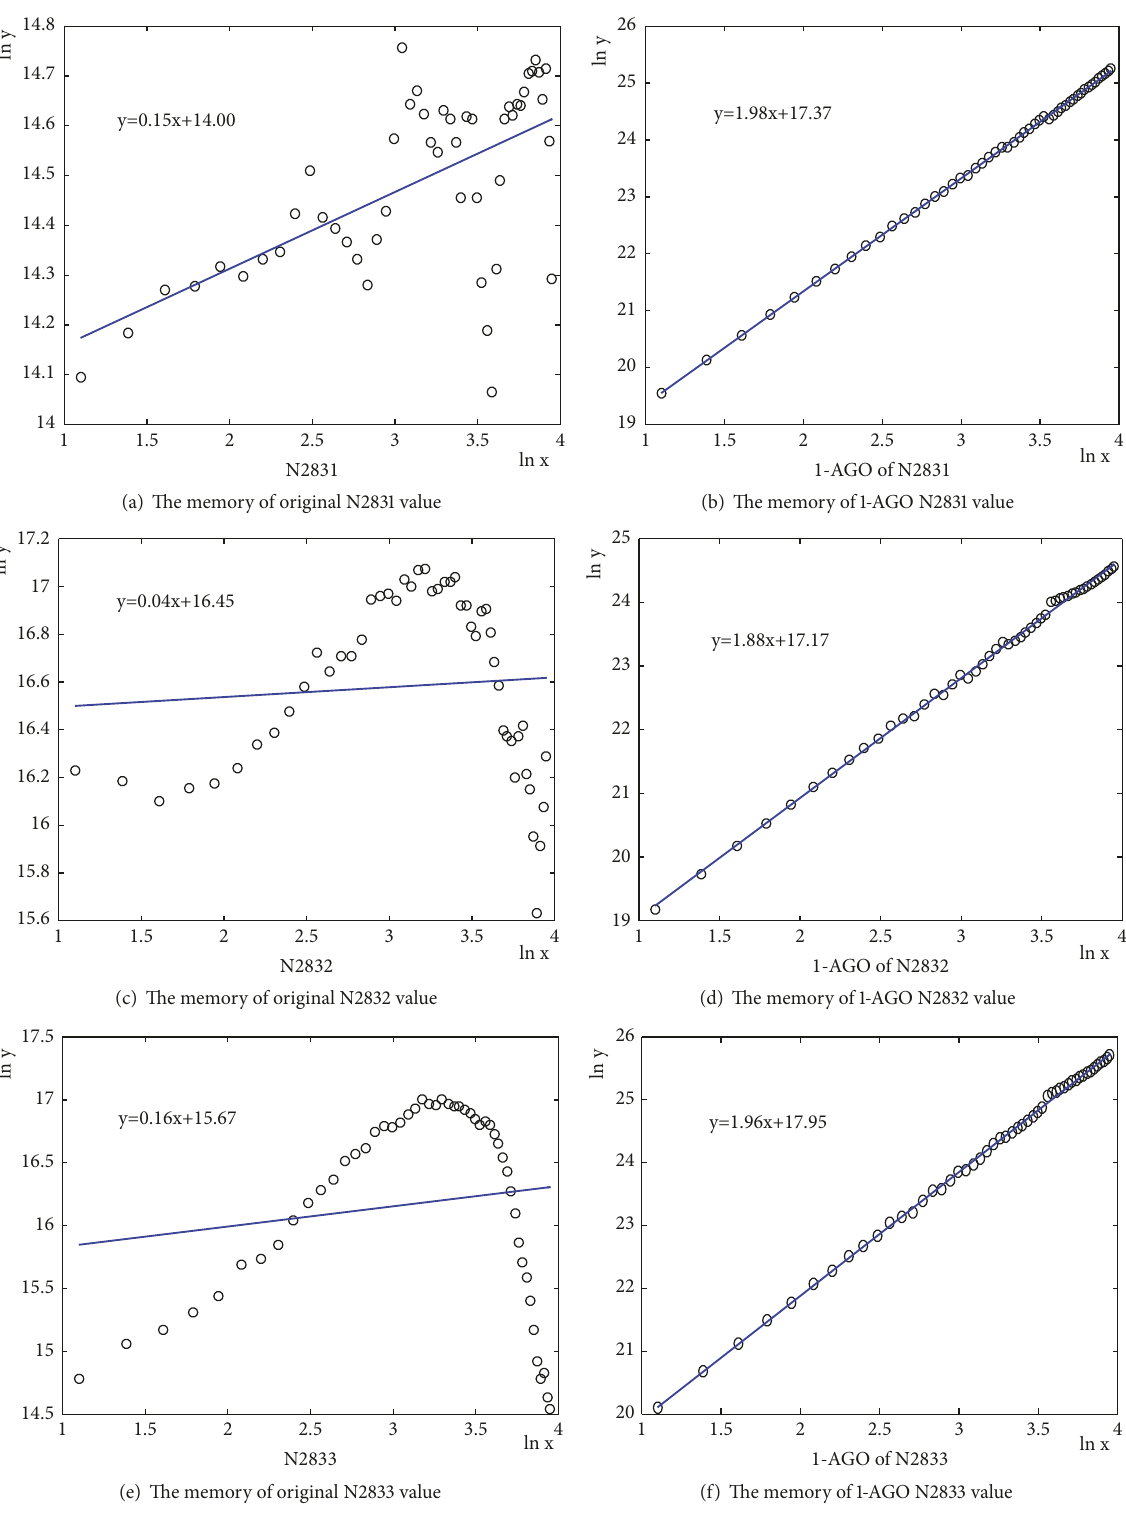
Figure 2: The memory of original value and one-order accumulation value for three groups of